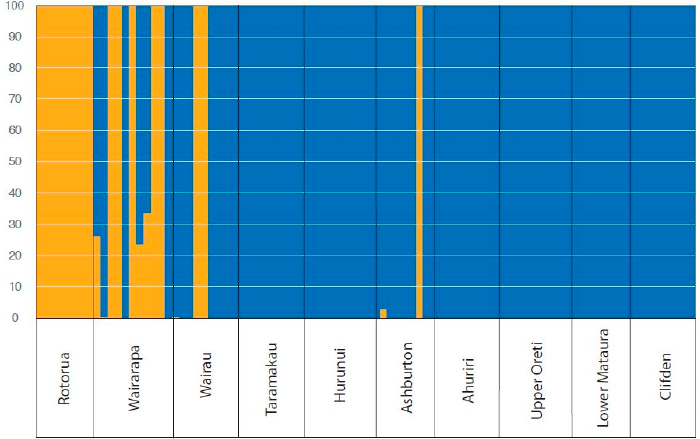
Figure 5 . Visualisation of the optimal number of clusters determined by fastSTRUCTURE [49] to explain genetic structure seen in black-billed gull SNPs across New Zealand. Labels on the x -axis correspond to individual catchments sampled.